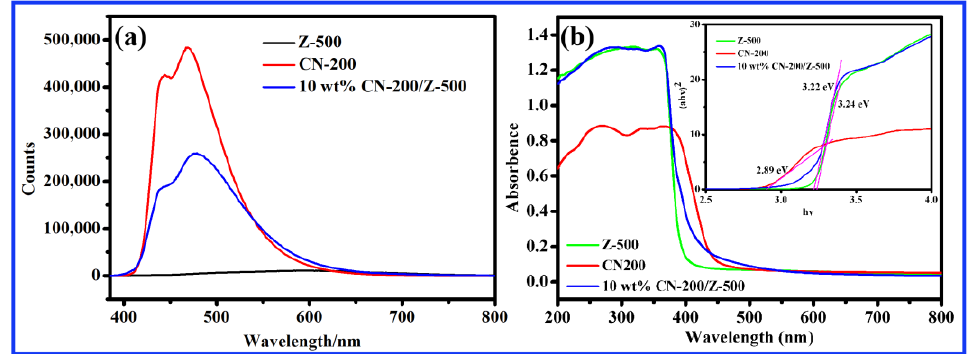
Figure 5. ( a ) Photoluminescence (PL) emission spectra of 10 wt.% CN-200/Z-500 composites, CN-200 and Z-500; ( b ) UV-Visible spectra of 10 wt.% CN-200/Z-500 composites, CN-200 and Z-500.